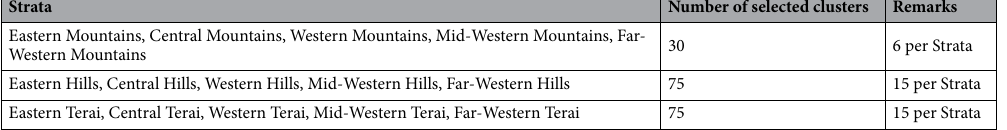
Table 1. Strata-wise distribution of sampling